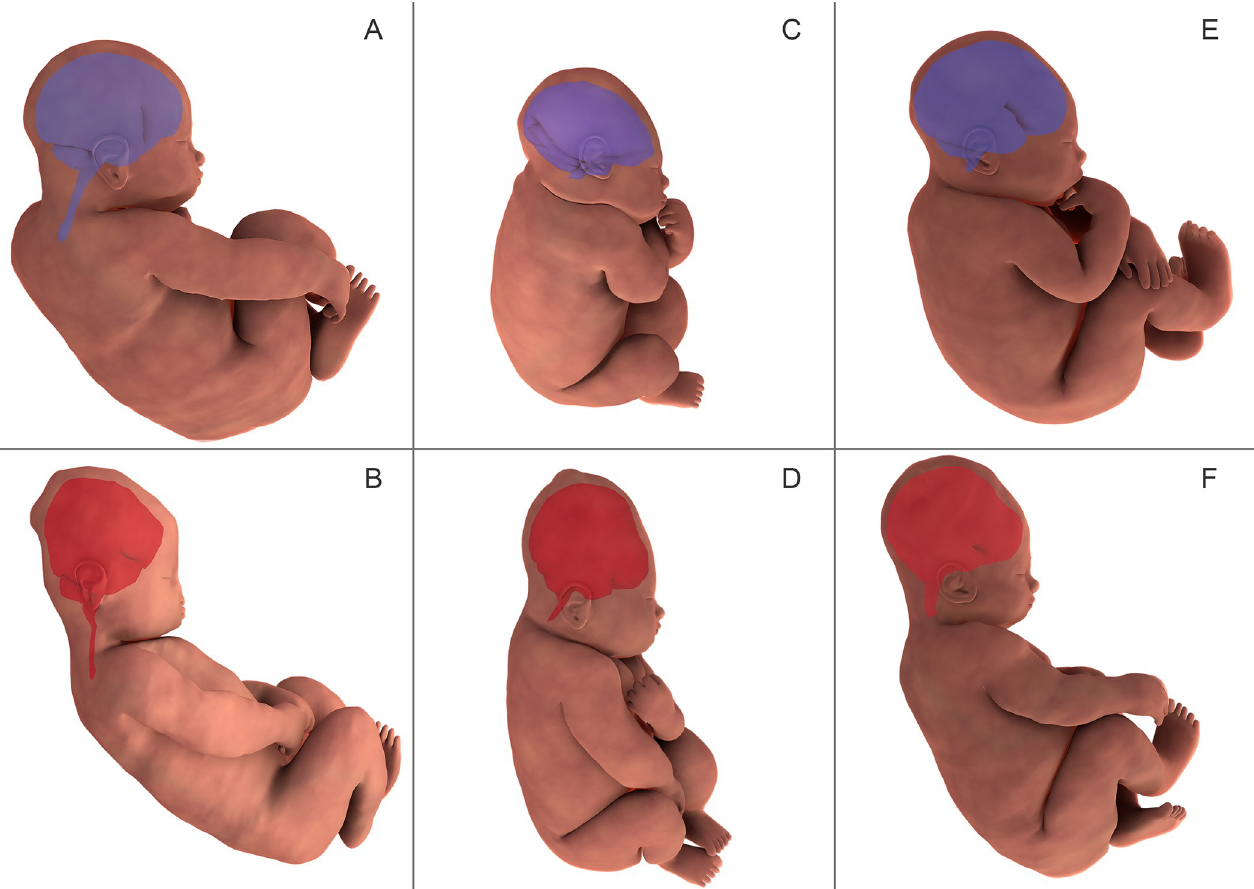
Fig 5. Three-dimensional fetal brain MRI reconstruction before labor (shown in purple in A, C, E) and during the second stage of labor (shown in orange in B, D, F) . In all patients, the fetal brain was observed to change in shape in the second stage of labor. This change in fetal brain shape mirrored the shifting of fetal skull bones observed during the second phase of